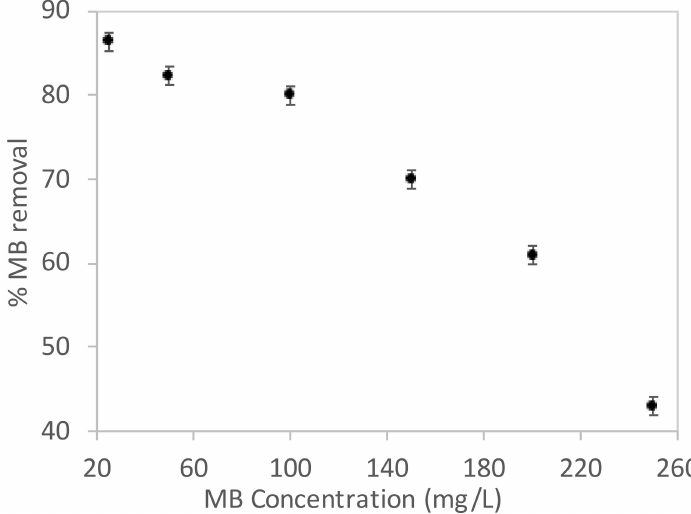
Figure 8. Effect of initial MB concentration (1.000 g of biomass, pH = 6.0, system was stirred at 150 rpm at 289 K for 3 h).